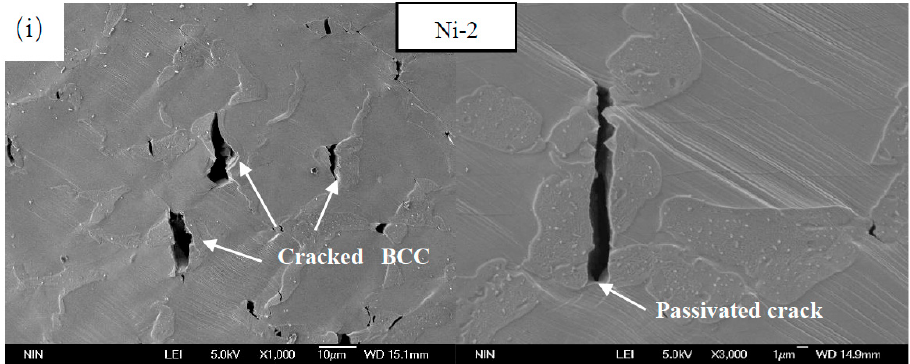
Figure 12. Deformed AlCoCrFeNiTi HEAs: ( a ) Ti-0.3; ( b ) Ti-0.5; ( c ) Al-0.3; ( d ) Co-1.5; ( e ) Co-2; ( f ) Fe-1.5; ( g ) Fe-2; ( h ) Ni-1.5; and ( i )